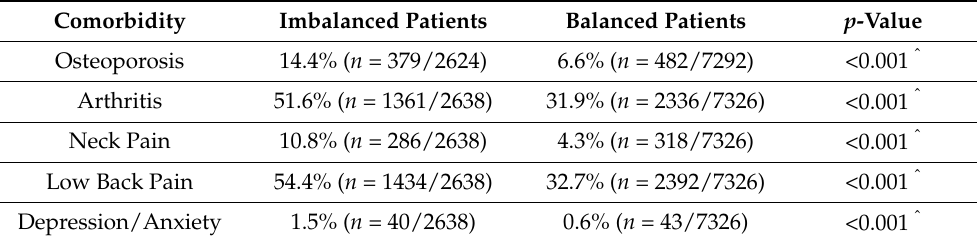
Table 1. Proportion of Imbalanced and Balanced patients reporting certain comorbidities. Comorbidity Imbalanced Patients Balanced Patients p -Value Osteoporosis 14.4% ( n = 379/2624) 6.6% ( n = 482/7292) <0.001 ˆ Arthritis 51.6% ( n = 1361/2638) 31.9% ( n = 2336/7326) <0.001 ˆ Neck Pain 10.8% ( n = 286/2638) 4.3% ( n = 318/7326) <0.001 ˆ Low Back Pain 54.4% ( n = 1434/2638) 32.7% ( n = 2392/7326) <0.001 ˆ Depression/Anxiety 1.5% ( n = 40/2638) 0.6% ( n = 43/7326) <0.001 ˆ Denominators reflect number of patients from each group with valid responses, may not reflect reported total of each group. ˆ Statistically significant: p <